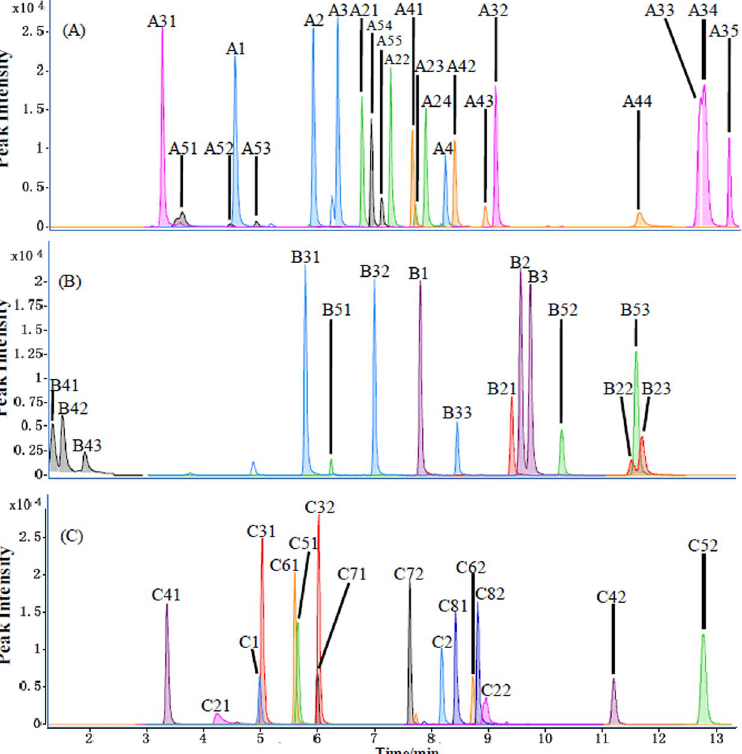
Figure 3. UHPLC-MS/MS chromatograms for some sets of the 5-AIQC-tagged amino analytes having the same pseudomolecular ions (m/z at unit resolution). ( A ) ion m/z 260 (A1: sarcosine; A2: β